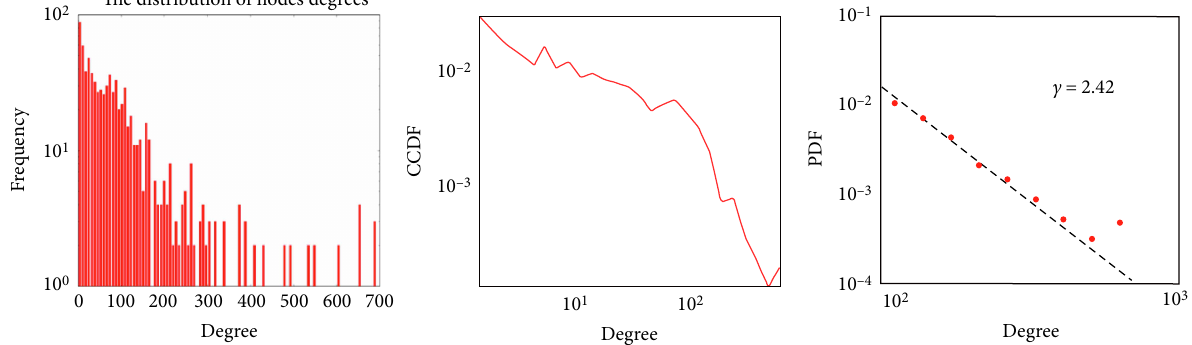
Figure 4: The distribution of nodes degrees in the taxi rides network, representing the number of possible destinations a passenger boarding a taxi at some location in the city may chose to go to. Note the surprisingly high number of origins with very low degrees – number of possible destinations. The nodes’ degrees are unaffected by the size or shape of the actual geographic region they refer to as all nodes refer to equally- sized square patches of the